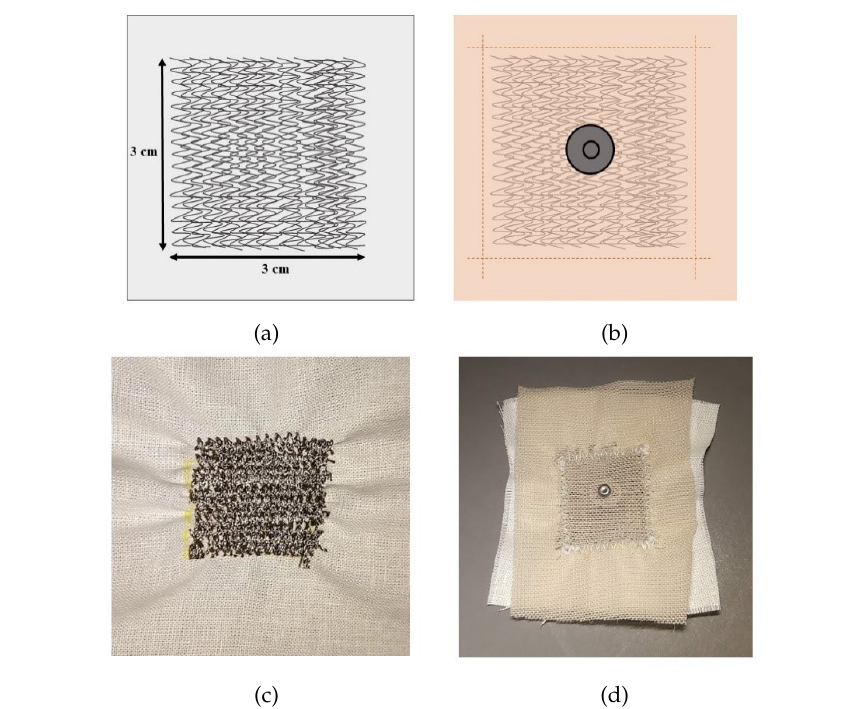
Figure 1. ( a ) Sewn electrode stitch design; ( b ) Design of fabric protective cover and snap connector; ( c ) Stitched electrode; ( d ) Complete electrode with protective cover and snap